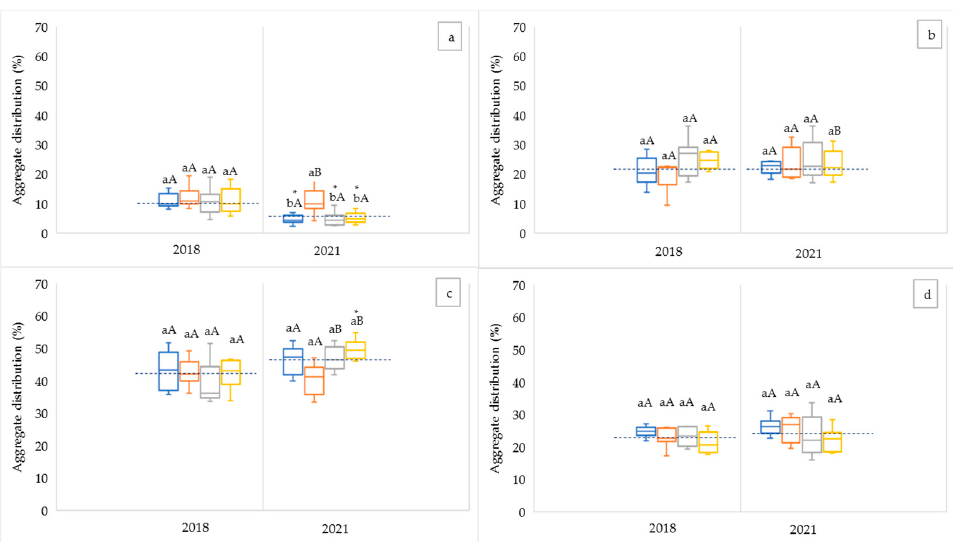
Figure 3. Soil water-stable aggregate size distribution (%) for conventional-tillage (CT; blue bars); saffron (D-S; orange bars); oats (D-O; grey bars), and lavender (D-L; yellow bars) treatments at 0–10 cm depth for ( a ) >2000 μ m, ( b ) 250–2000 μ m, ( c ) 53–250 μ m and ( d ) <53 μ m. The different lowercase letters above the error bars for the same soil layer indicate significant differences between managements at p < 0.05. Different capital letters are indicating differences in depth between 0–10 cm layer and 10–30 cm layer which is represented in Figure 4. Each cultivation system (*) represents significant differences between managements compared to olive monocrop conventional tillage system in 2018 (control treatment) by Dunnett’s test ( p < 0.01); missing asterisks denote non-significant differ- ences.